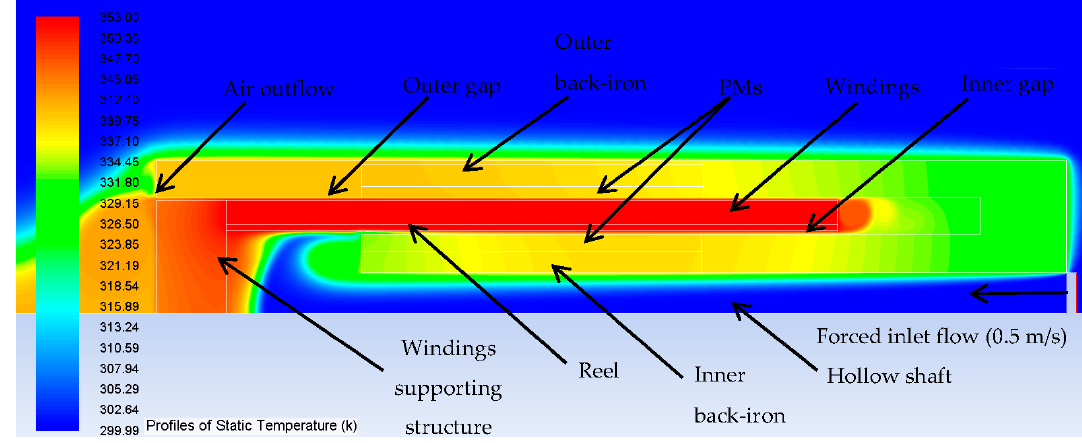
Figure 9. Results of 2D axisymmetric thermal simulation of the full length of actuator design with dimensions found for the uncoupled model but with a constant temperature of 353 K at the windings.